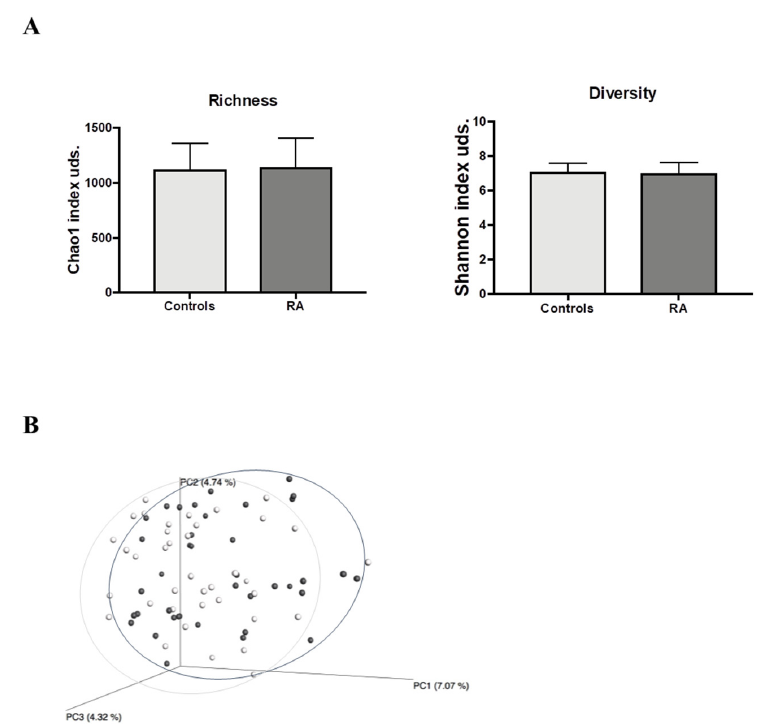
Figure 1. Fecal bacterial community structure in RA patients and controls ( A ) Richness (Chao-1 Index) and diversity (Shannon Index) of RA patients and controls. ( B ) Principal coordinate analysis (PCoA) using unweighted UniFrac distances. Each point corresponds to a community coded according to the group. The percentage of variation explained by the plotted principal coordinates is indicated on the axes. RA patients (dark grey dots), controls (light grey dots). Analysis of similarities (ANOSIM) p = 0.070. RA, Rheumatoid arthritis.